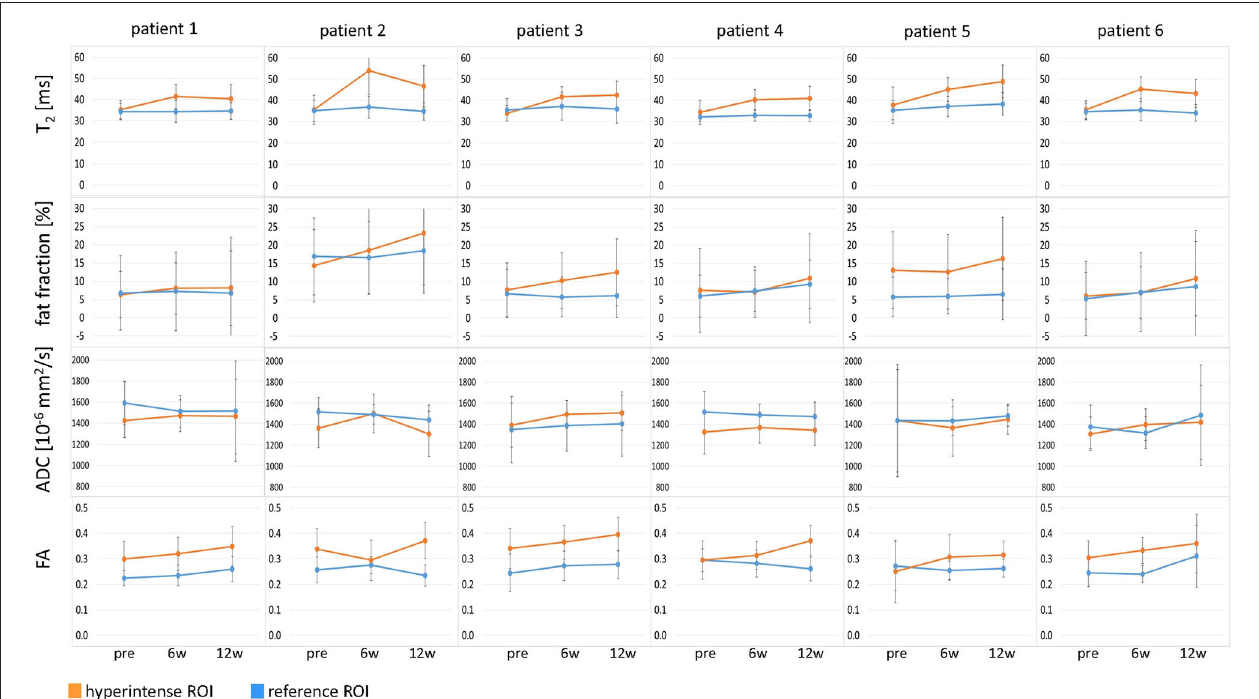
FIGURE 3 | Time courses of T 2 , fat fraction, apparent diffusion coefficient (ADC), and fractional anisotropy (FA) in all six patients at time points pre-BTX, 6 weeks (6w), and 12 weeks (12w) post-BTX. The values are displayed as mean values in the hyperintense ROI (orange) and the reference ROI (blue). The error bars show the standard deviation in the ROIs. ROI, region of interest; BTX, botulinum toxin